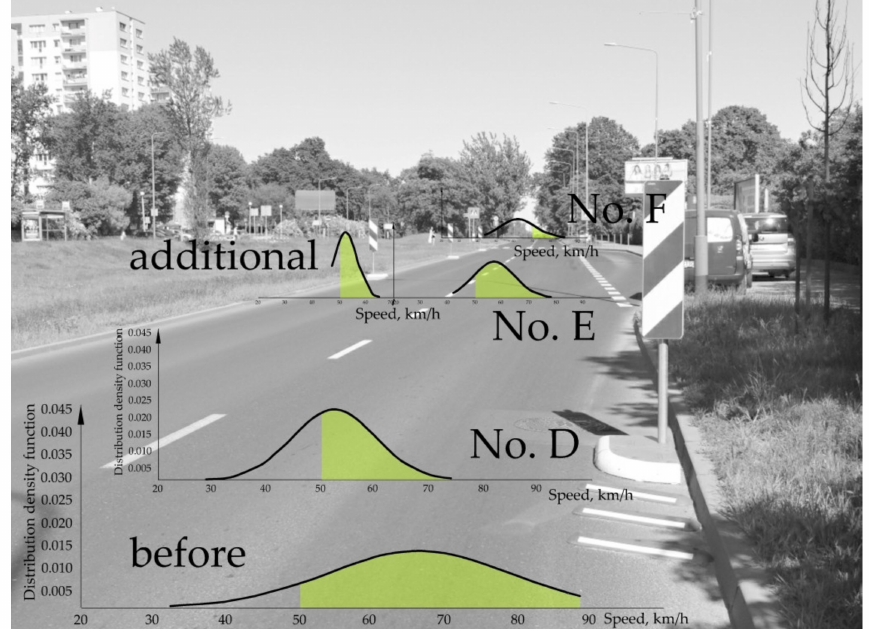
Figure 7. Gaussian curve of speed distribution on the test sections on the eastbound carriageway (ca. 130 m approach along a straight